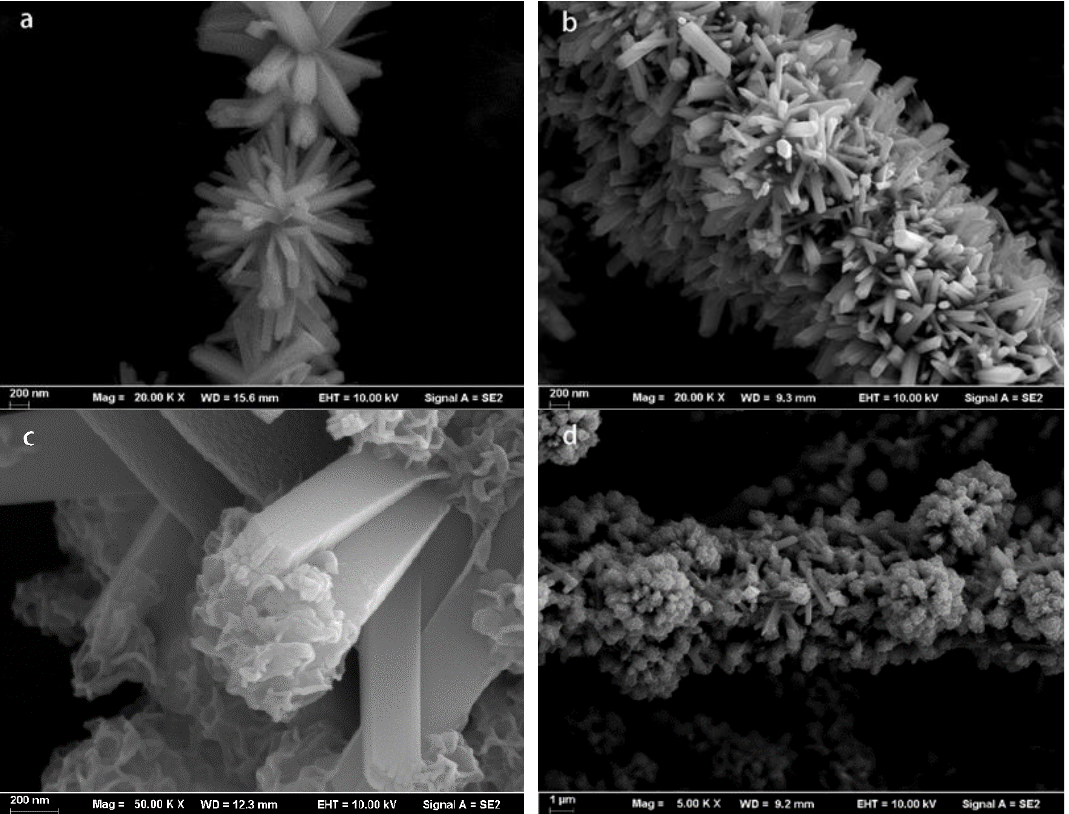
Figure 3. FESEM images of PI/TiO 2 nanocomposites ( a , b ) and PI/TiO 2 @MoS 2 nanocomposites ( c , d ). The PI/TiO 2 @MoS 2 nanocomposite was characterized by powder X-ray diffraction (XRD), as shown in Figure 4 . Strong XRD diffraction peaks at 2θ = 27.45°, 36.09°, 41.23°, 54.32°, 56.64°, and 69.01° were clearly observed, consistent with the (110), (101), (111), (211), (220), and (301) faces, respectively, of rutile phase TiO 2 indexed to the JCPDS card 21-1276 with a space group of P42/mnm (a = b = 4.593Å and c = 2.959Å ), similar to the